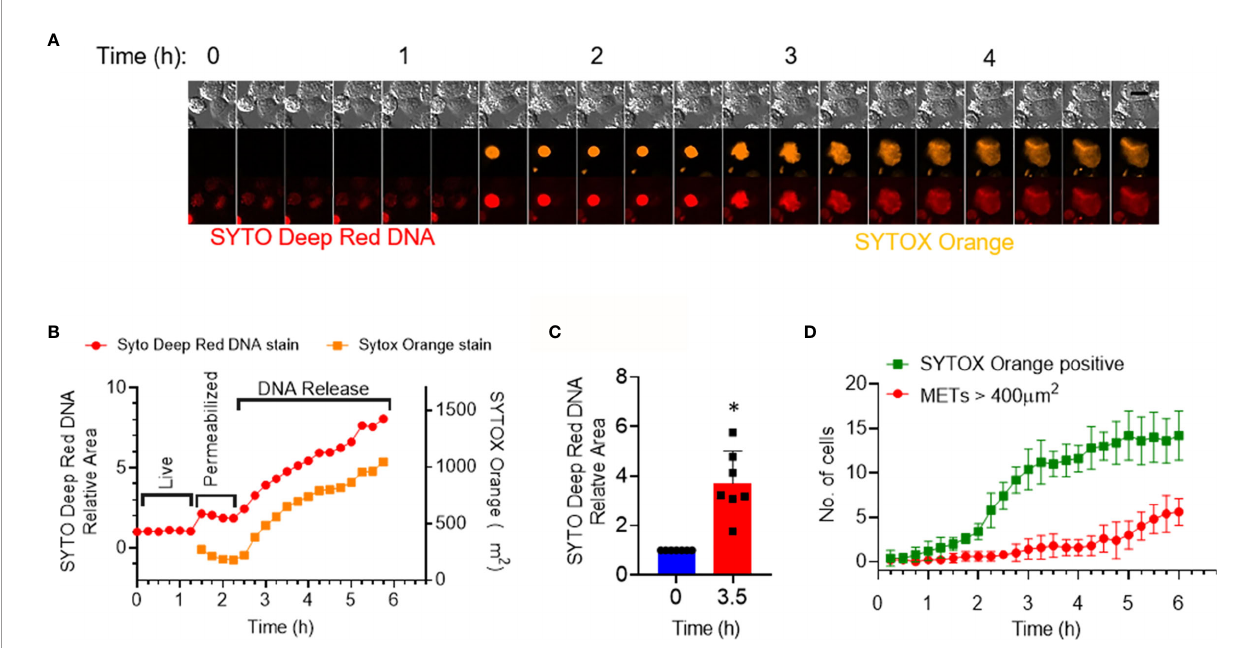
FIGURE 2 | eCIRP stimulation of THP-1 cells causes morphological changes indicating MET formation. THP-1 cells were treated with rmCIRP (1 µg/ml). (A) A montage of time-lapse images of a single cell shows the process of MET formation by rmCIRP treatment. Images from the time-lapse microscopy show swelling, permeabilization, and staining of SYTOX Orange in the nucleus and subsequently the release and spread of DNA. SYTO Deep Red DNA staining (bottom panel) shows the nuclear DNA. Scale bar (upper right), 20 µm. (B) The nuclear swelling and DNA release were quanti fi ed by the area measurement of SYTO deep red DNA and SYTOX Orange staining depicted in panel (A) . It shows two stages of morphological changes, permeabilization (nuclear swelling) and subsequent release of DNA. (C) The fold change of the area of SYTO Deep Red DNA staining of 7 individual cells. *p <0.05 vs. 0 h. (D) The number of total SYTOX Orange positive cells and METs is represented in this graph. METs are bigger than 400 µm 2 and are plotted through time. The data collected was the average of 5 different microscopic fi elds from the cell culture treated with 1 µg/ml